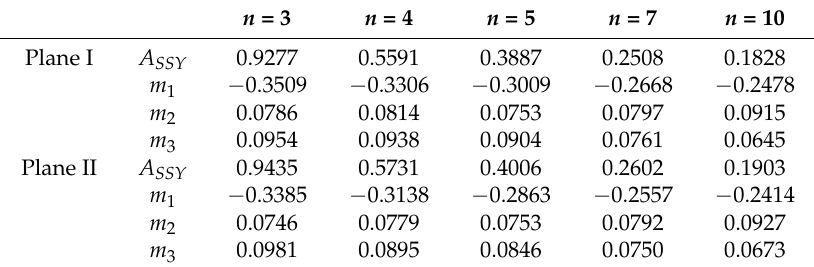
Table 2. Values of coefficients for polynomial A-T relationship, plane I and II.